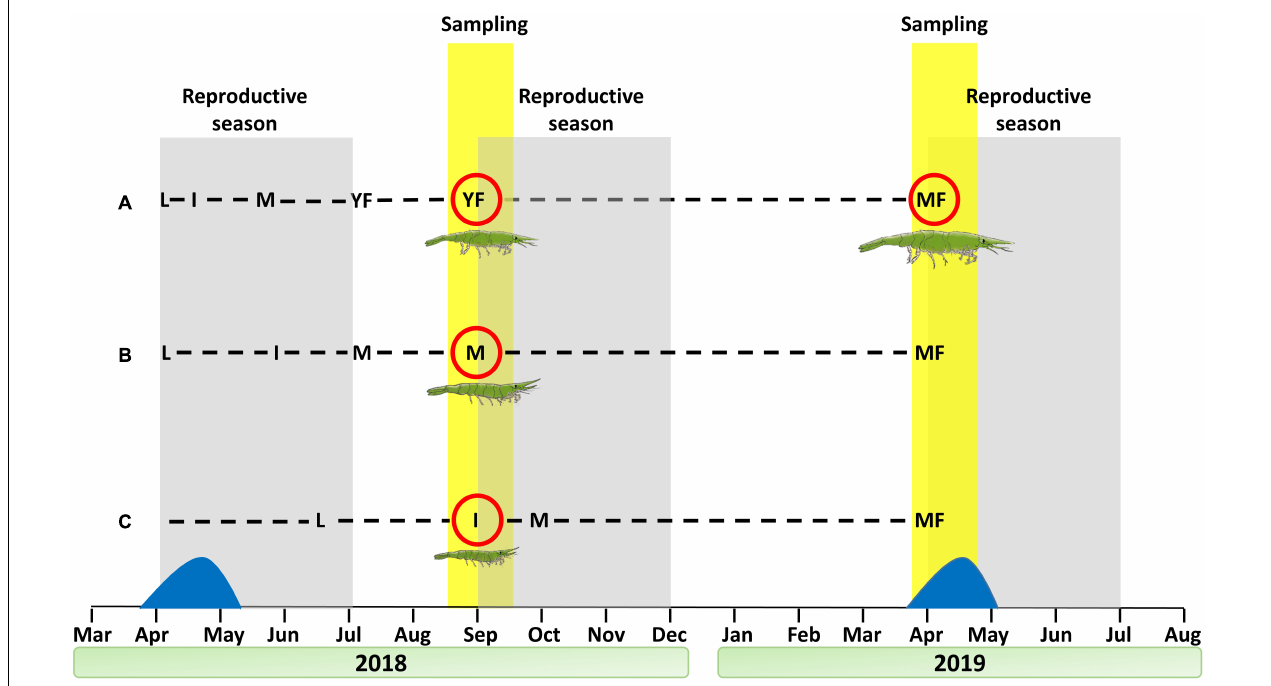
FIGURE 2 | Sampling regimen for the construction of a Hippolyte inermis transcriptomic library. Shrimp were sampled at the beginning of the reproduction seasons of September 2018 and April 2019. Dashed lines represent different cohorts. (A) Larvae hatched in April 2018 and quickly passed through the male stage (due to the diatom peak), becoming young females in September 2018 and mature females in April 2019. (B) Larvae hatched in April 2018 and matured slowly as males, despite the diatom peak, thus remaining males in September 2018 and becoming mature females in April 2019. (C) Larvae hatched in mid-June, thus remaining immature in September 2018 and becoming mature females in April 2019. Sampled stages are ringed with a red circle. Reproductive seasons and sampling periods are indicated with gray and yellow backgrounds, respectively. The diatom peak is represented in blue. L = larvae, I = immature, M = male, YF = young female, MF = mature